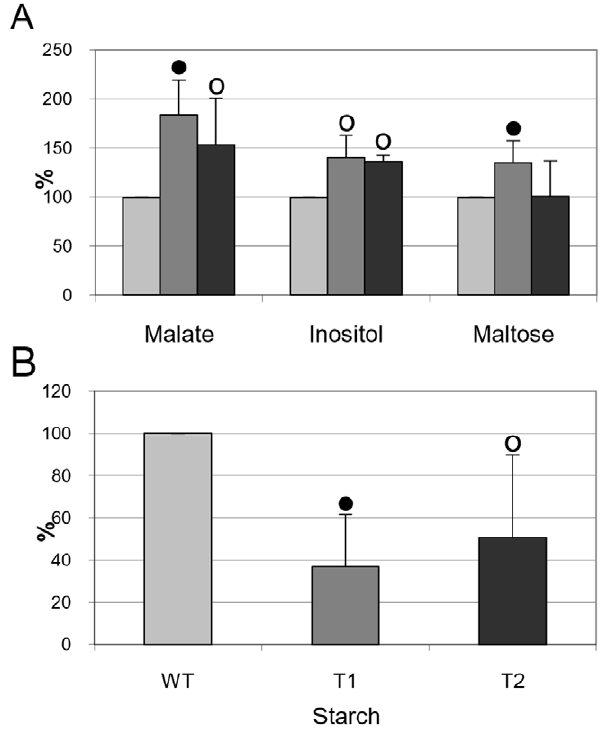
Figure 2. Relative amounts of sugars (A) and starch (B) in wild- type (WT) and TPS1 -transgenic (T1, T2) leaves. Bars and error bars represent the mean 6 SE derived from three independent experiments. Filled and open circles denote differences significant at P =0.01 and P =0.05 ( t probe) levels, respectively, when compared with the wild- type. The carbohydrate concentrations in wild-type leaves in the three independent experiments were as follows: malate 19.4, 16.7, 17.6 m mol/ g FW; inositol 0.89, 0.9, 0.94 m mol/g FW; maltose 0.51, 0.53, 0.52 m mol/g FW; starch 4.4, 1.7, 0.5 m mol hexose equivalent/g FW. These are regarded as 100% values for comparison with the equivalent samples from the transgenic leaves.